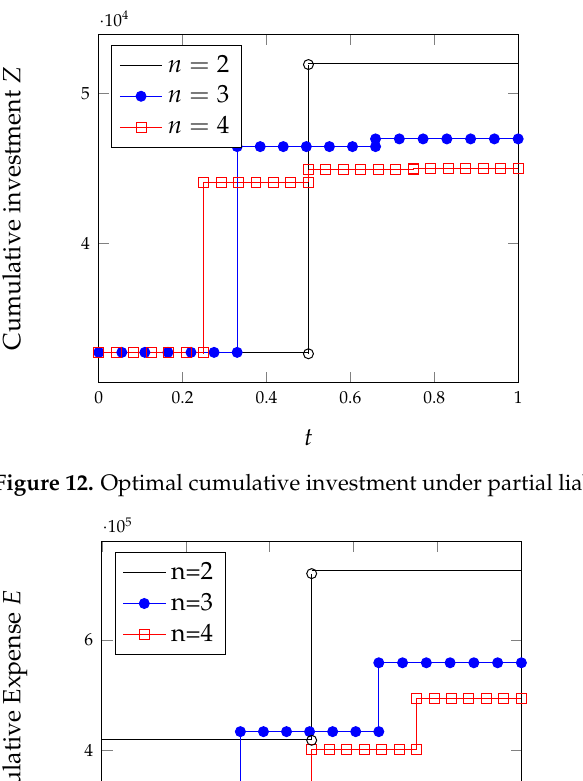
Figure 11. Optimal cumulative expense E under partial liability and GL2 model.